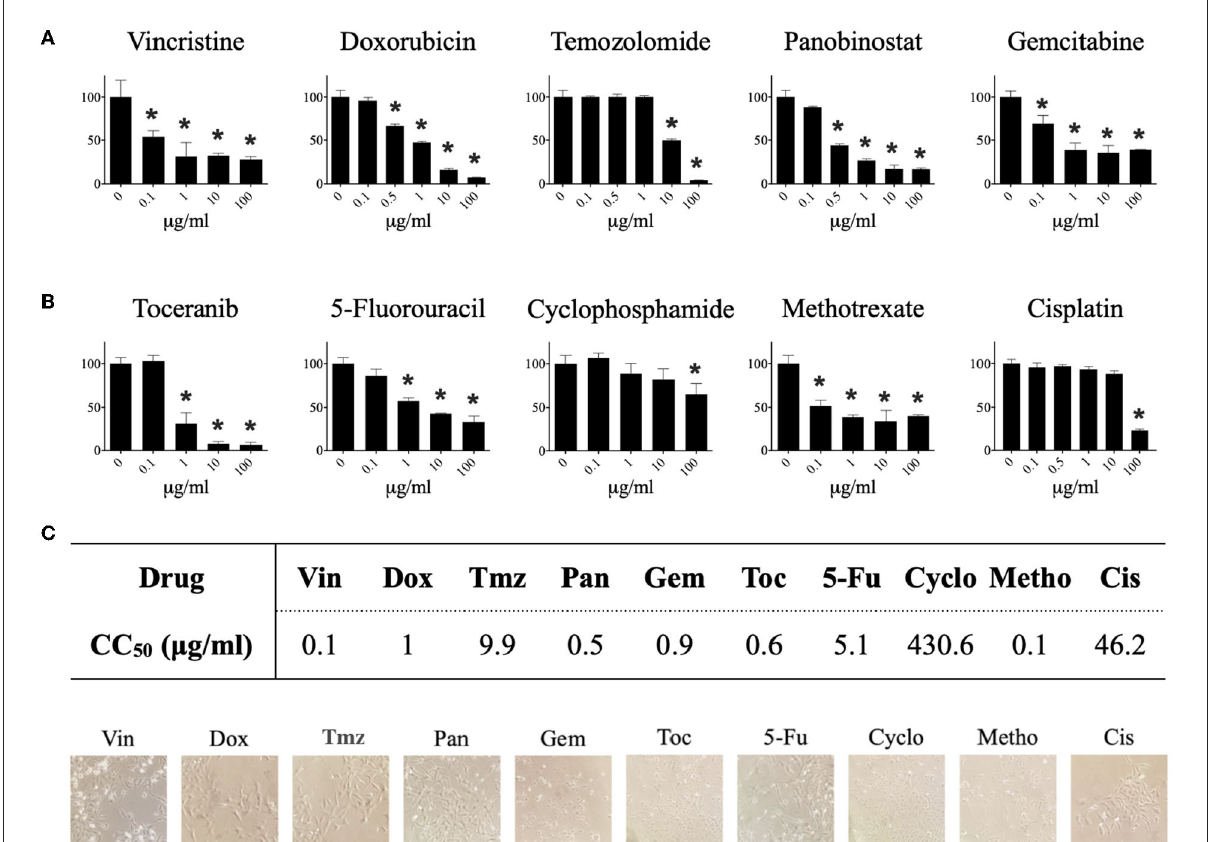
FIGURE1 Effect of different pharmacological agents on the viability of the CTVT cell line. CTVT cells (5x10 3 /well) were exposed to different concentrations (from 0 to 100 µ g/ml) of the drugs Vin, Dox, Tmz, Pan, Gem, Toc, 5-Fu, Cyclo, Metho, and Cis for 24h. Relative cell viability was determined by the Alamar-blue assay. (A) Each bar graph represents the average of 6 independent measurements ± SD. Statistical significance was performed using Dunnett’s post hoc test ( * p < 0.05). (B) The CC 50 of each drug was calculated from the viability data obtained with the Alamar blue assay using the Quest GraphTM ED50 Calculator program (AAT Bioquest, Inc.). The CC 50 is expressed in µ g/ml. (C) Representative photographs taken under a bright field microscopy of TVT cells treated with the CC 50 of each drug. Magnification: 40 × . Vin, vincristine; Dox, doxorubicin; Tmz, temozolomide; Pan, panobinostat; Gem, gemcitabine; Toc, toceranib; 5-Fu, 5-fluorouracil; Cyclo, cyclophosphamide; Metho, methotrexate; Cis,